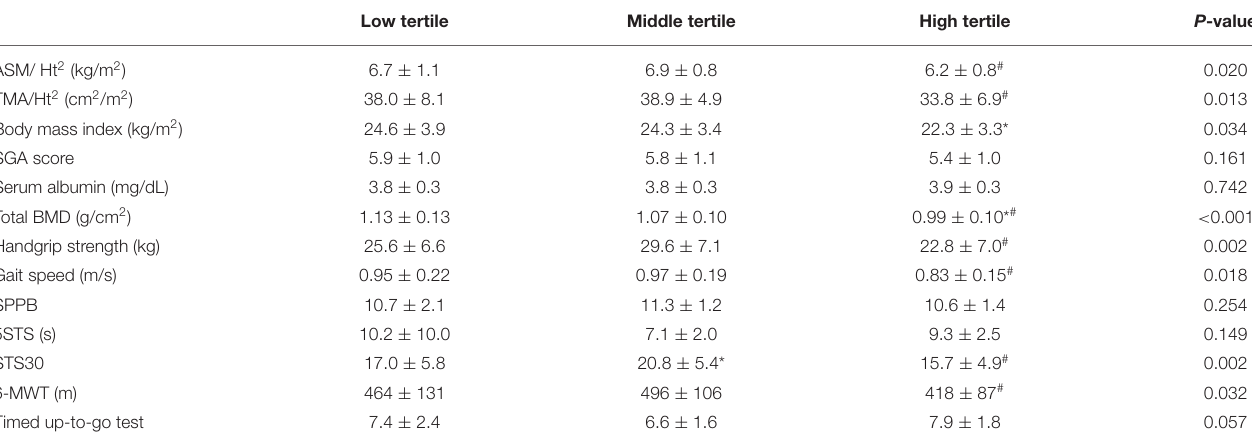
TABLE 2 | Comparison of muscle mass indices, nutritional and physical performance according to tertiles of alkaline phosphatase. Low tertile Middle